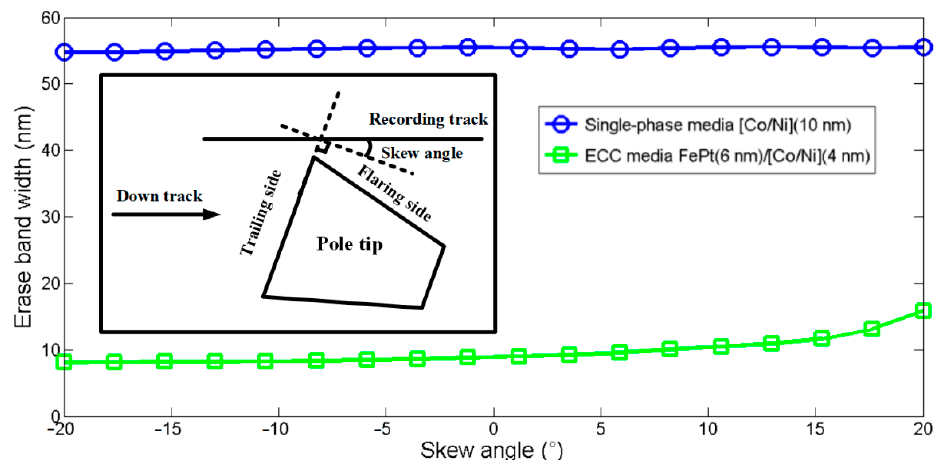
Figure 3. EBW as function of the skew angle for single-phase media [Co/Ni] 5 (10 nm) and ECC media FePt(6 nm)/[Co/Ni] 5 (4 nm). Inset: the ABS view of pole tip, the skew angle is defined as the angle between recording track and normal direction of trailing side.